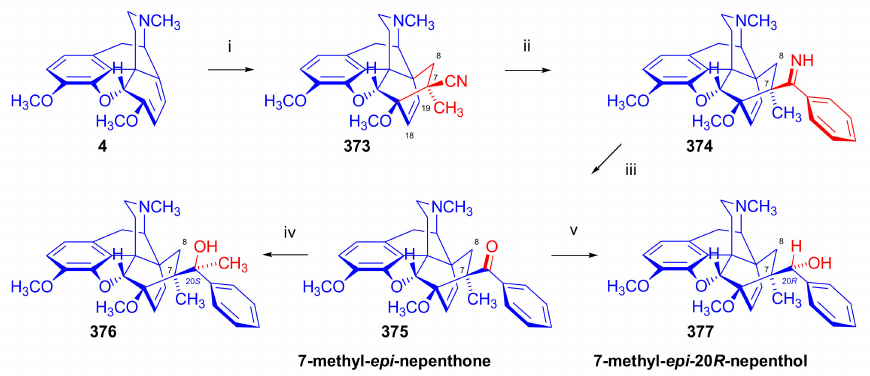
Figure 95. Synthesis of 7-methy- epi -nepenthone and its derivatives. Reagents and conditions : (i): methacrylonitrile, xylene, reflux, 40 h, 40%; (ii): one equiv. PhMgBr, benzene, reflux, 18 h, 65%; (iii): 50% AcOH (aqueous), 100 ◦ C, 45 min, 76%; (iv): MeMgI, benzene, reflux, 3 h; and (v): sodium borohydride, 2-ethoxyethanol.